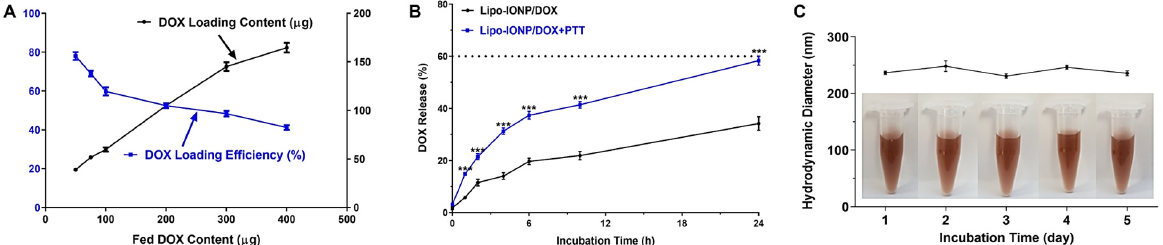
Figure 5. Loading and release of DOX and the size stability of Lipo-IONP/DOX. ( A ) DOX loading content and efficiency of the Lipo-IONP/DOX. ( B ) DOX release profiles with and without laser irradiation. ( C ) Size stability profiles of the Lipo-IONP/DOX. With increasing the DOX fed content, the DOX loading content increased, but, at the same time, the loading efficiency decreased. Based on the results, 200 μ g of DOX feeding amount leading to a loading of 105 μ g, was chosen for further studies. With laser irradiation above 47 °C (transition temperature of the liposome) for 10 min, a burst release of DOX was observed. A statistically significant difference between the groups was compared by Student’s t-test using Prism software (GraphPad). *** p < 0.001 (Lipo-IONP: liposomal iron oxide nanoparticle and Lipo-IONP/DOX: doxorubicin-loaded liposomal iron oxide nanoparticle).